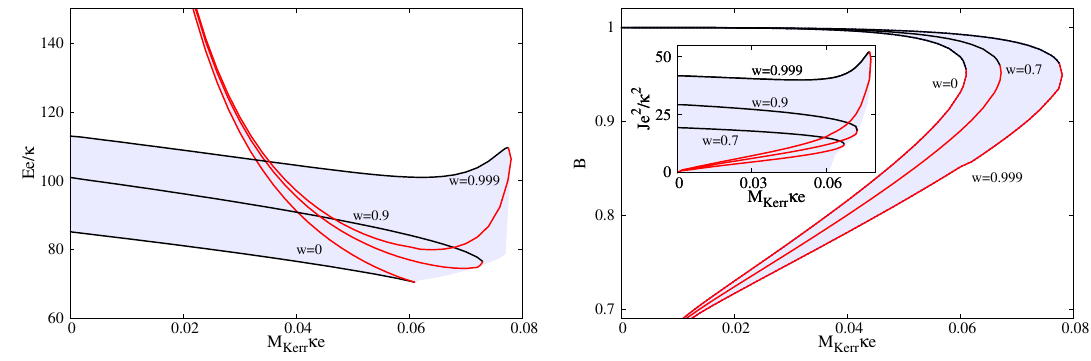
Figure 5 . The Skerrmions mass-energy (left panel) or baryon charge (right panel) or angular momentum (inset) ar shown vs: the coupling parameter (cid:20)eM Kerr . The shaded area corresponds to the explored domain of